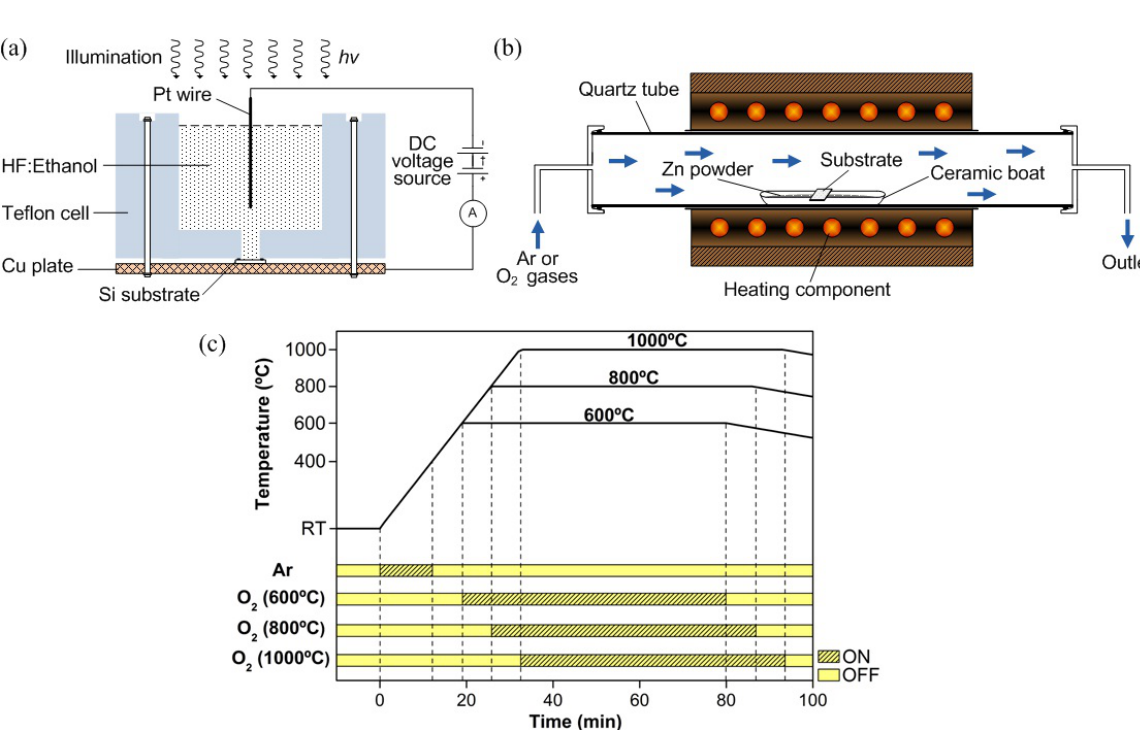
Figure 1. Schematic of ( a ) electrochemical etching setup; ( b ) tube furnace system and ( c ) time chart for zinc oxide (ZnO) nanorod growth by the thermal evaporation